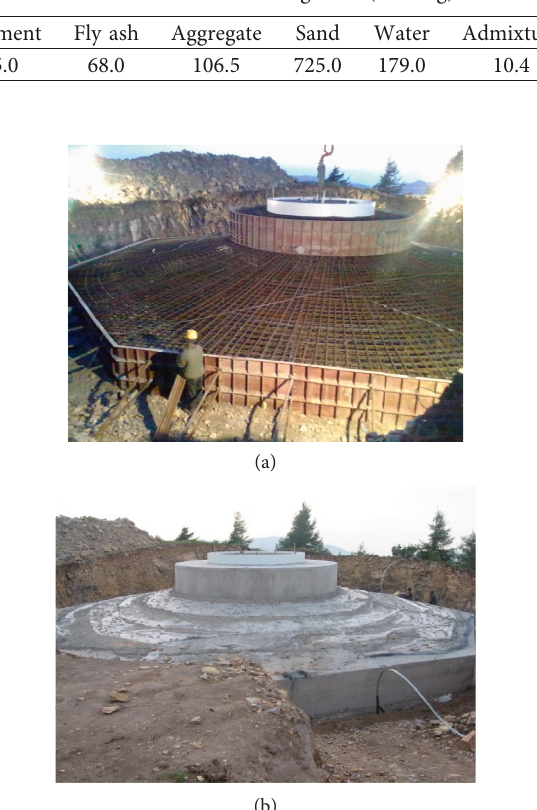
Figure 1: Photos of Foundation 1. (a) Before pouring. (b) After demolding.